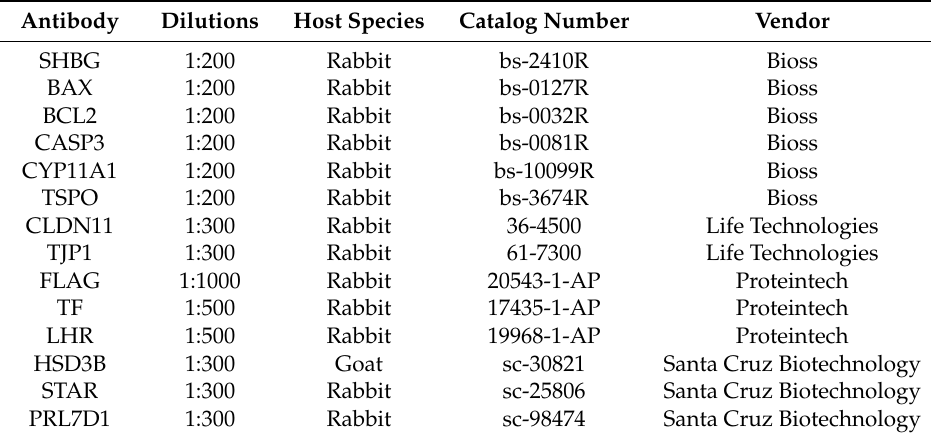
Table 2. Antibodies used in Western